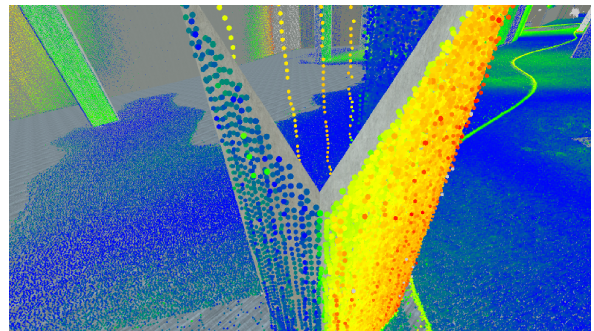
Figure 3: The ability to show datasets simultaneously in the user’s VR view, increases level of comprehension substantially. The discrepancy between the left grey part of the as-design BIM column and the point cloud is smaller compared to the right side, hence the typical CloudCompare blue/green and yellow/red colourisation.